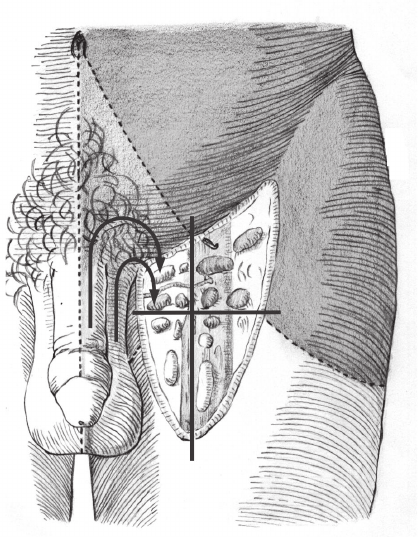
Figure 1: Schematic drawing of lymphatic drainage of inguinal nodes. There is a cross with its middle point in the saphena hiatus. The penile and scrotum lymphatic drainage is performed, by the upper internal quarter (arrows).